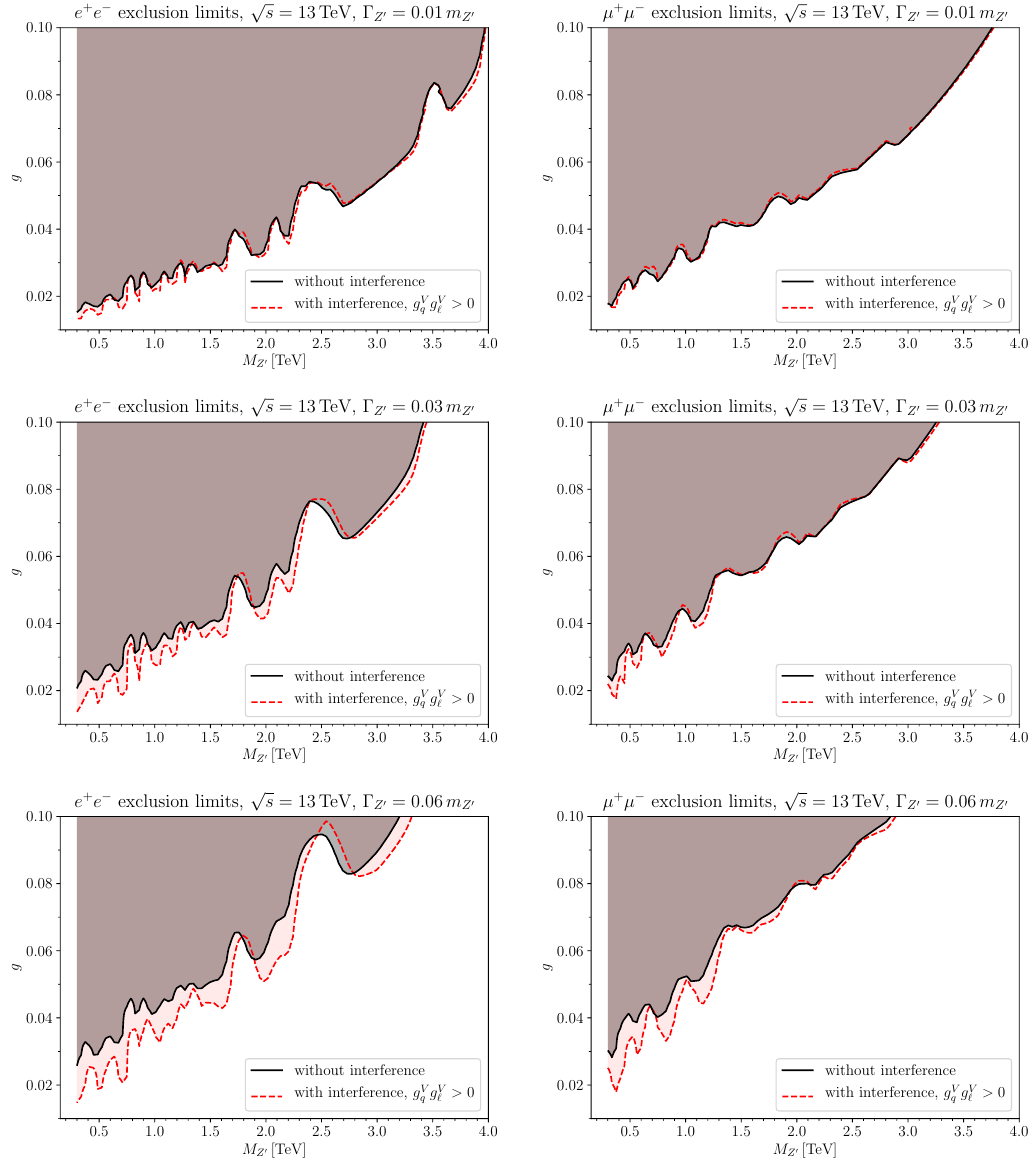
Figure 6 . Same as (cid:12)gure 4 but separately for the e(cid:11)ective coupling to electrons (left column) and muons (right